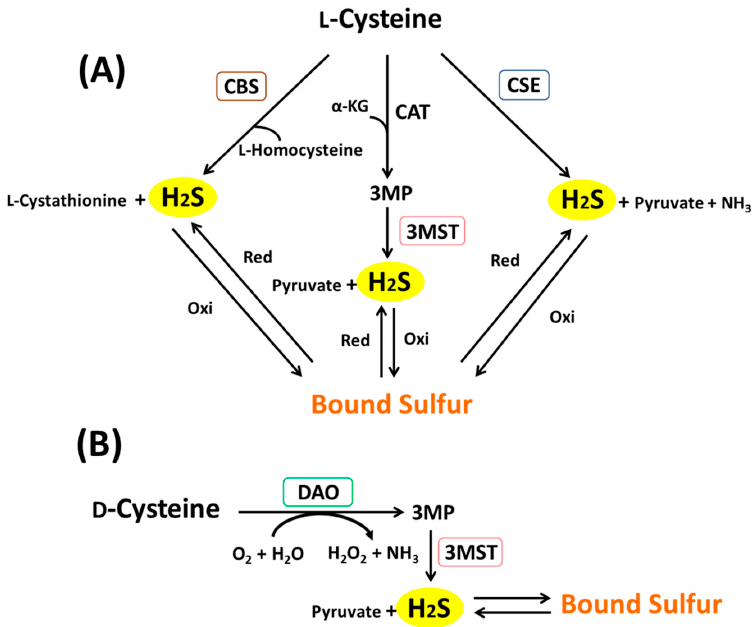
Figure 2. H 2 S and bound sulfur generation from L -cysteine ( A ) and D -cysteine ( B ) in mammalian tissues. CBS: cystathionine β -synthase; CSE: cystathionine γ -lyase, CAT: cysteine aminotransferase, MST: mercaptopyruvate sulfurtransferase, α -KG: α -ketoglutarate, DAO: D -amino acid oxidase, 3MP: 3-mercaptopyruvate, red: reduction; oxi: oxidation.